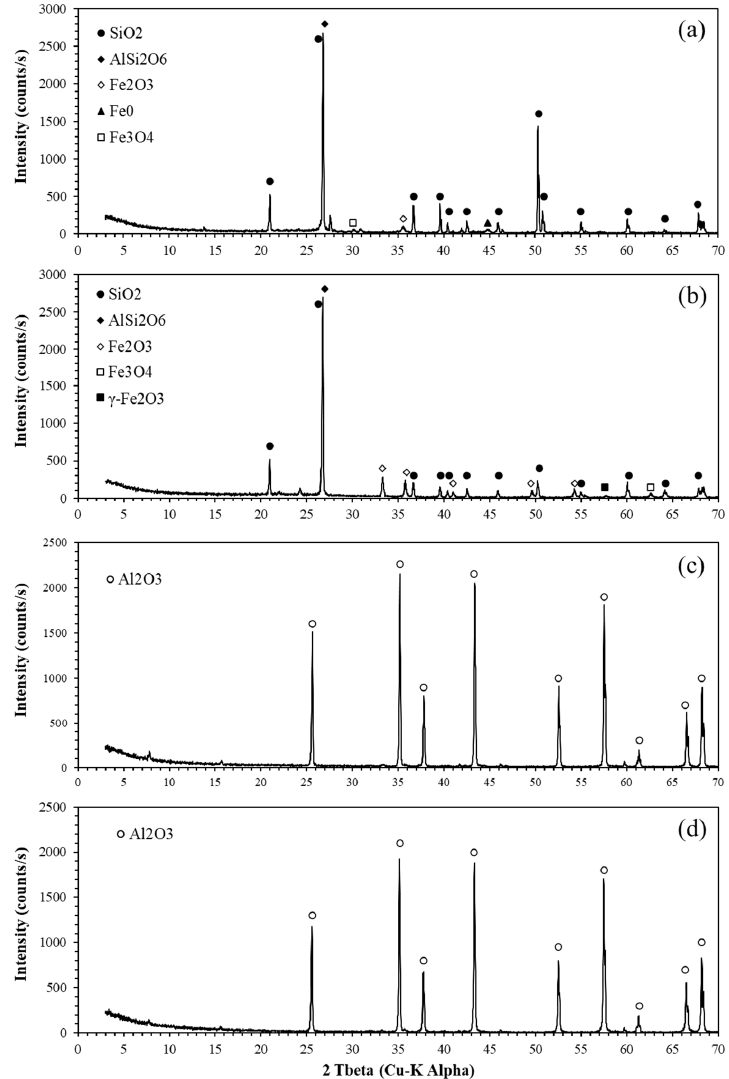
Figure 1. XRD patterns of WCI and α -alumina: ( a ) raw WCI, ( b ) WCI after roasting, ( c ) raw α -alumina, and ( d ) α -alumina after roasting. Table 2. BET surface area of WCI and α -alumina before and after roasting at 1250 ◦ C.